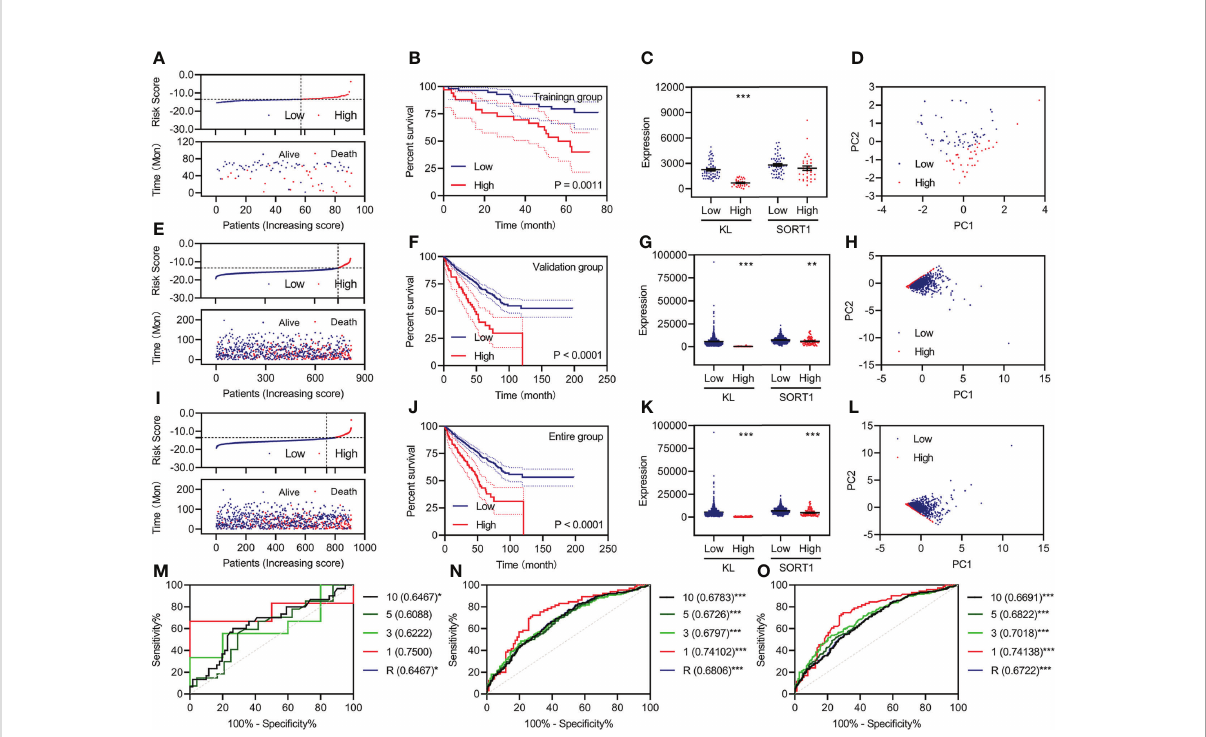
FIGURE 3 Development and validation of the prognostic model. (A, E, I) Risk score (up) and status (down) for each KC patient in the training group (A) , validation group (E) , and entire group (I) . (B, F, J) KM curve of a prognostic model in the training group (B) , validation group (F) , and entire group (J) . (C, G, K) Expression of KL and SORT1 among patients in the training group (C) , validation group (G) , and entire group (K) with different risk values. (D, H, L) Distribution of KC patients in the training group (D) , validation group (H) , and entire group (L) with different risk values. (M – O) Time-dependent ROC curve of a prognostic model in the training group (M) , validation group (N) , and entire group (O) . **p < 0.01; ***p <